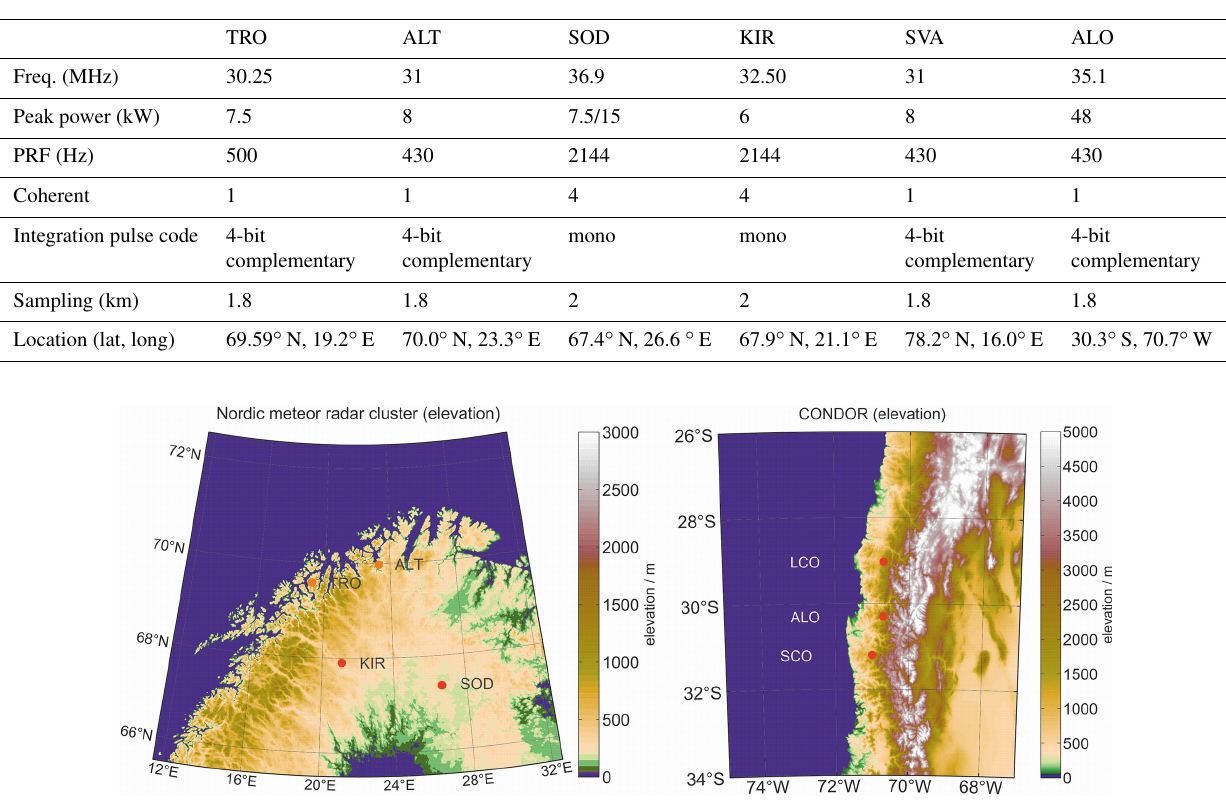
Table 1. Technical parameters of the Nordic Meteor Radar Cluster and CONDOR (ALO).